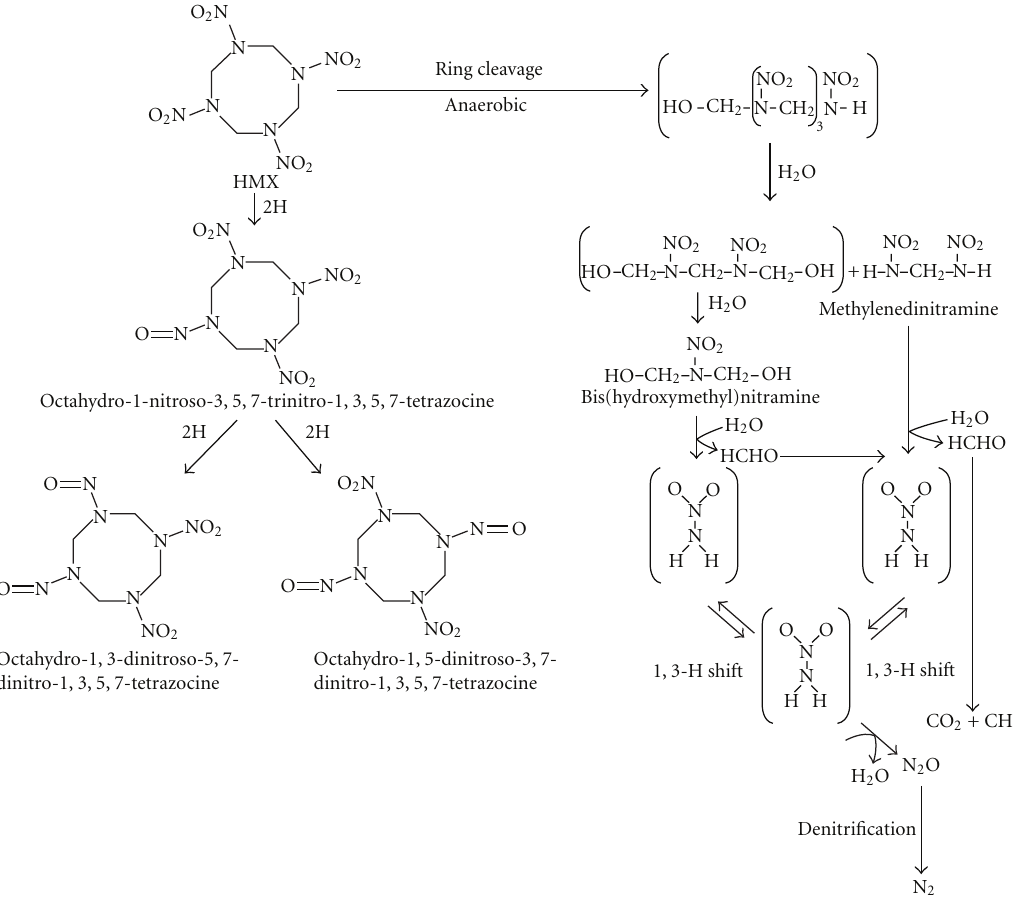
Figure 6: Biological transformation pathway of HMX [33]. Reproduced with kind permission from The International Union of Pure and Applied